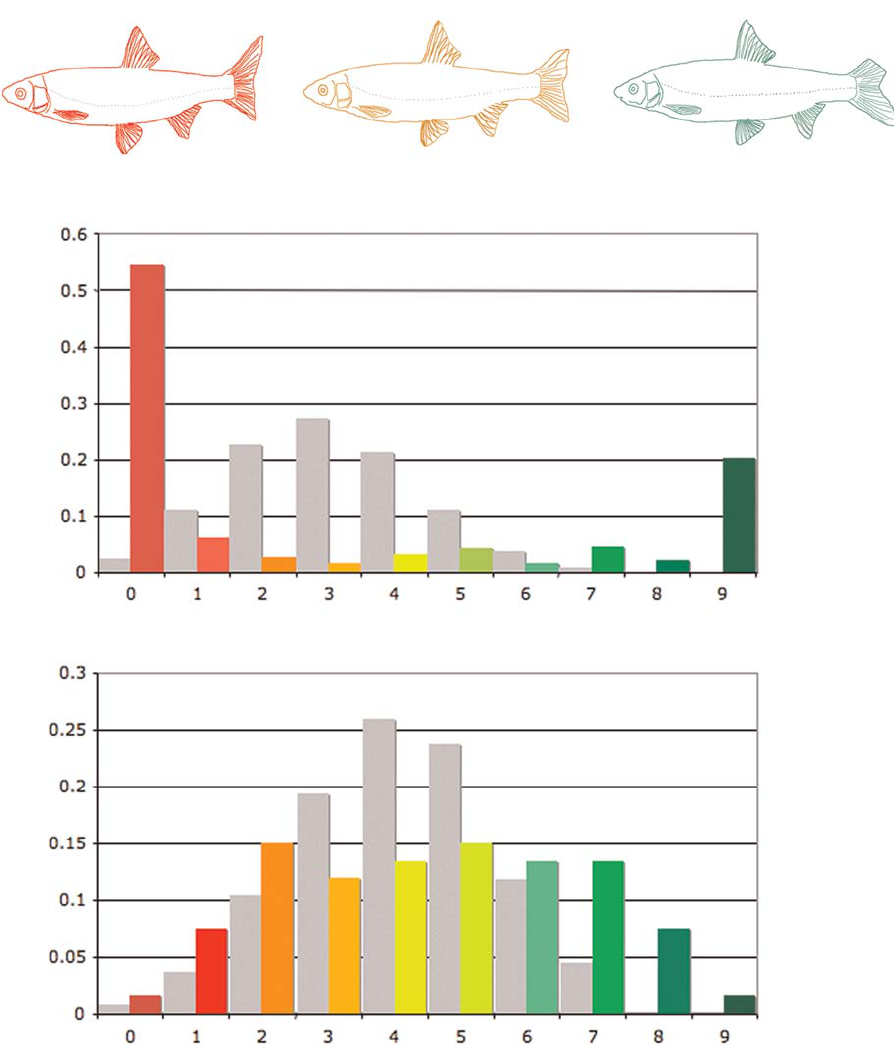
Figure 8. MORPHOLOGY AND GENOME DILUTION . The graphs show the distribution of individuals for each genome dilution class (x-axis) as a function of i) their probability based on numbers of specimens; y-axis (first graph) ii) their probability based on numbers of combinations; y-axis (second graph). The color gradient (observed values) extends from red (T5) to green (H5). The intermediate morphologies and genomic combinations are shown in yellow-orange, with theoretical values shown in gray (see the text for more detail). The fish morphologies shown are a simplistic representation of the morphological gradient (not all intermediate morphologies are represented).